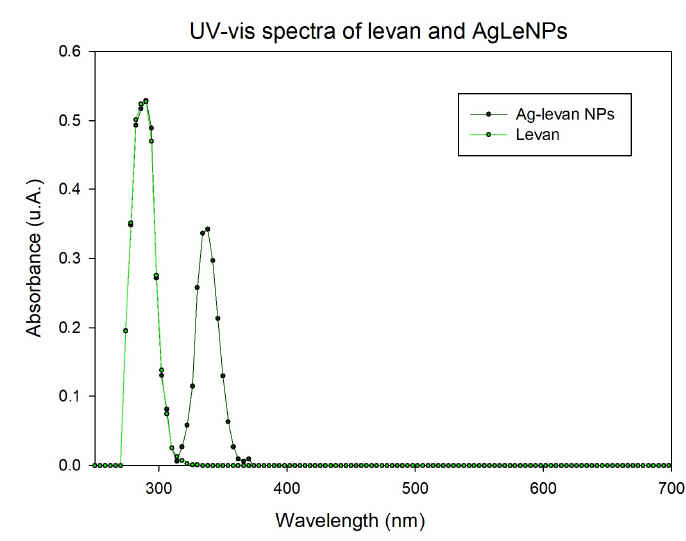
Figure 3. UV-vis spectra of levan and AgLeNPs.